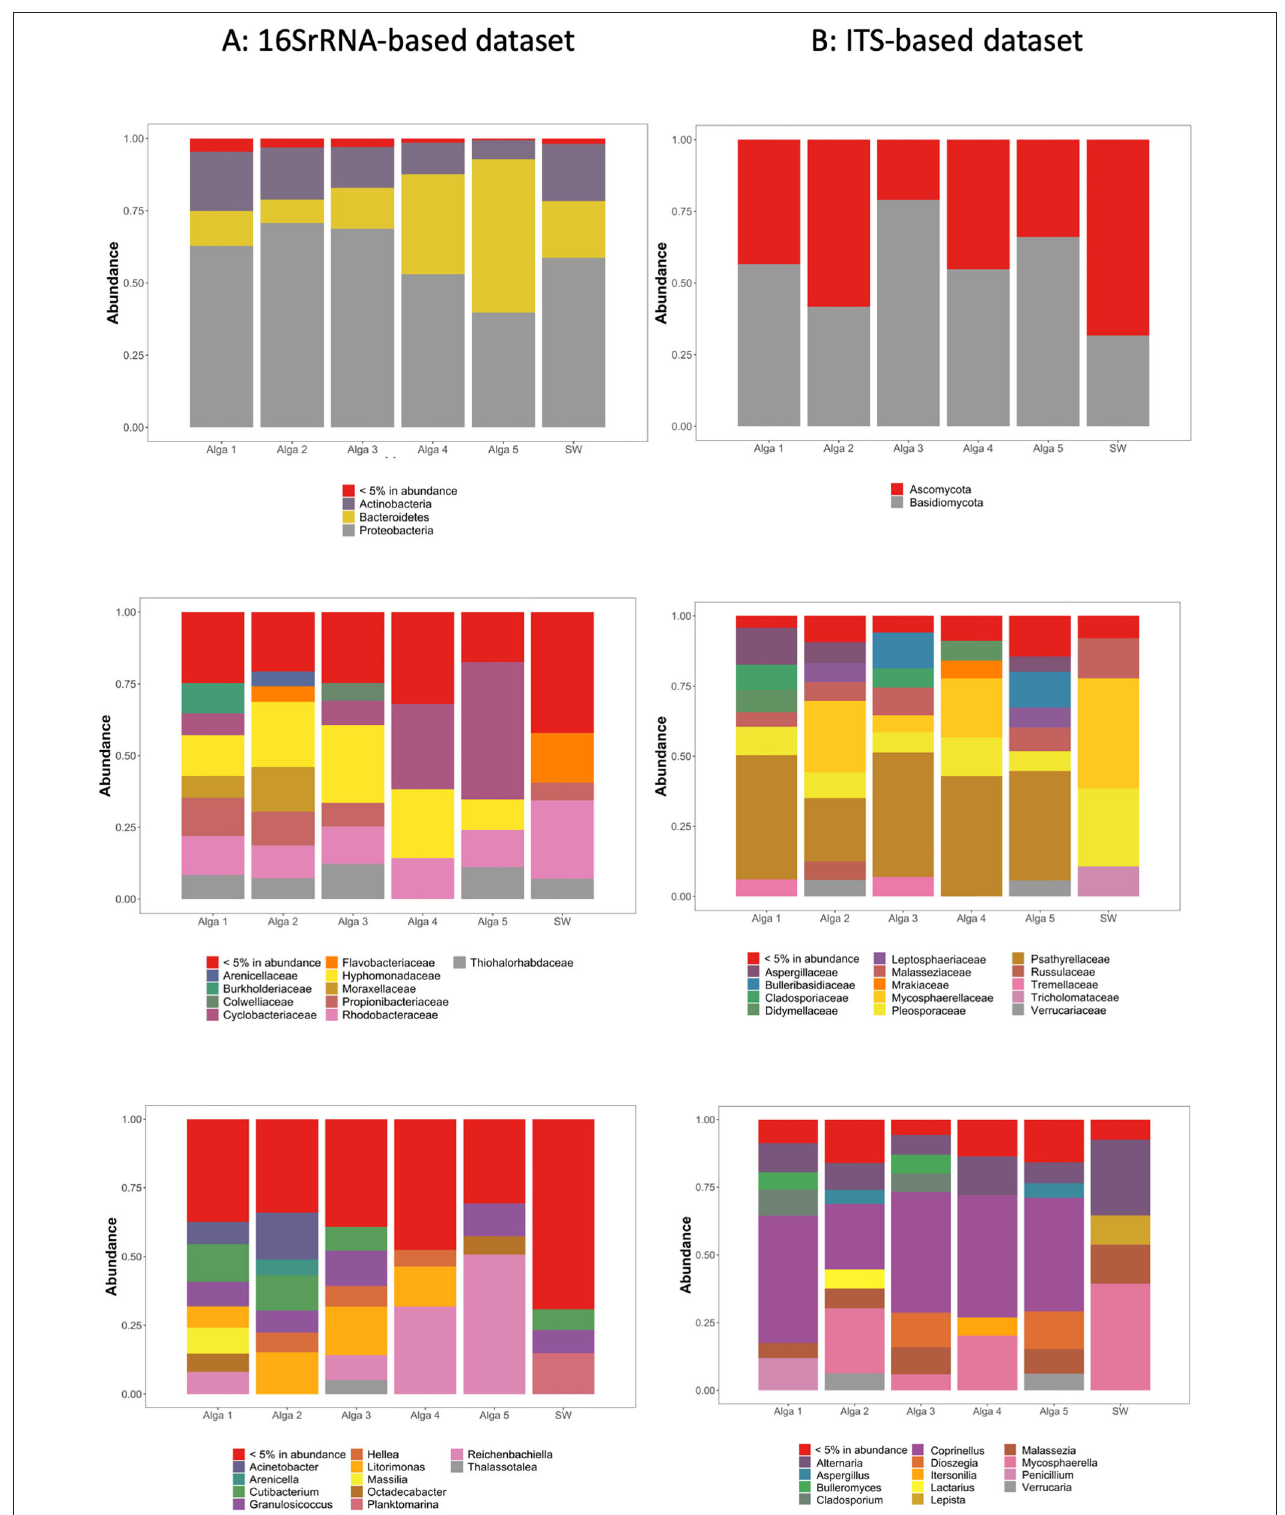
FIGURE 2 | Relative abundance of the most abundant ASVs in our dataset, clustered according to their taxonomic assignation within each S. latissima individual and seawater sample (SW) based on 16S rRNA genes relative abundance (A) and ITS genomic fragments relative abundance (B) . Top panel: Assignation at the phyla level. Middle panel: Assignation at the family level. Bottom panel: Assignation at the genus level.